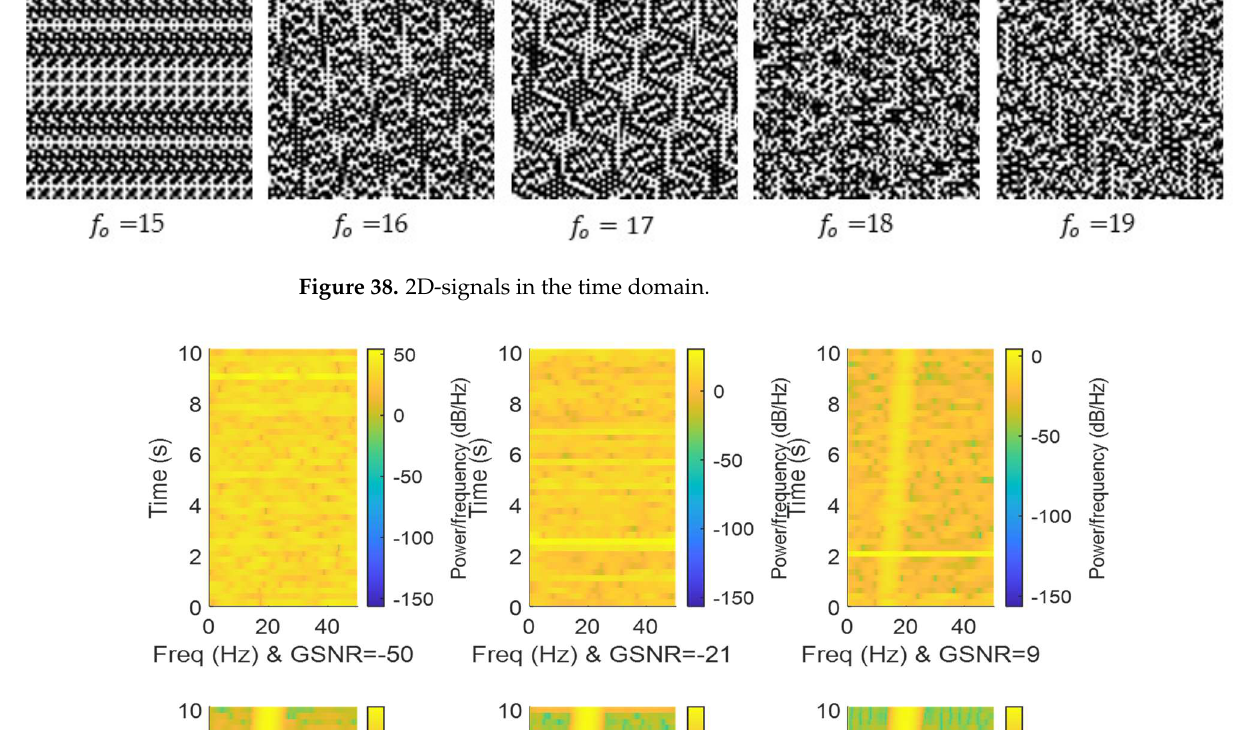
Figure 38. 2D-signals in the time domain.